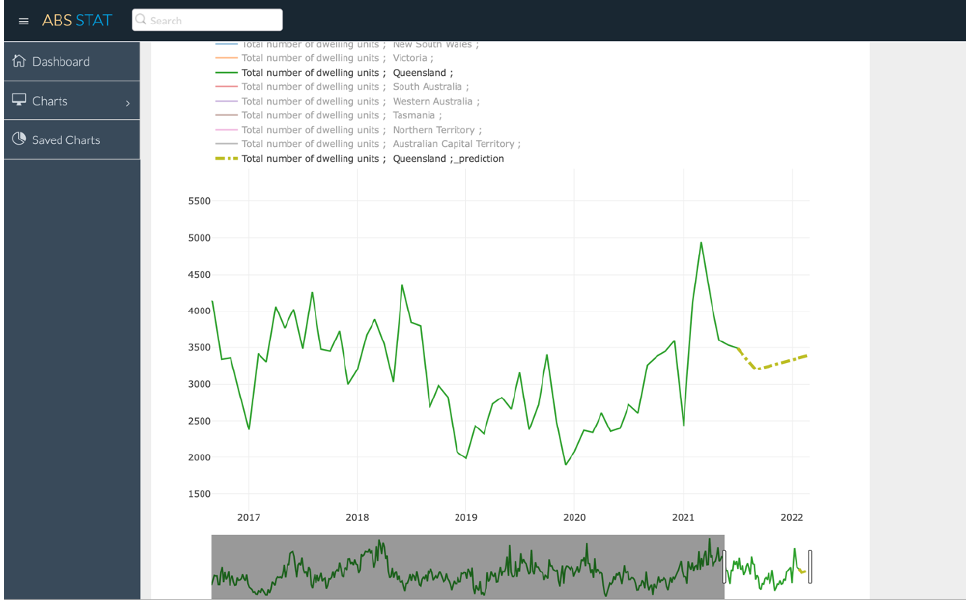
Figure 4. Screenshot of data visualisation